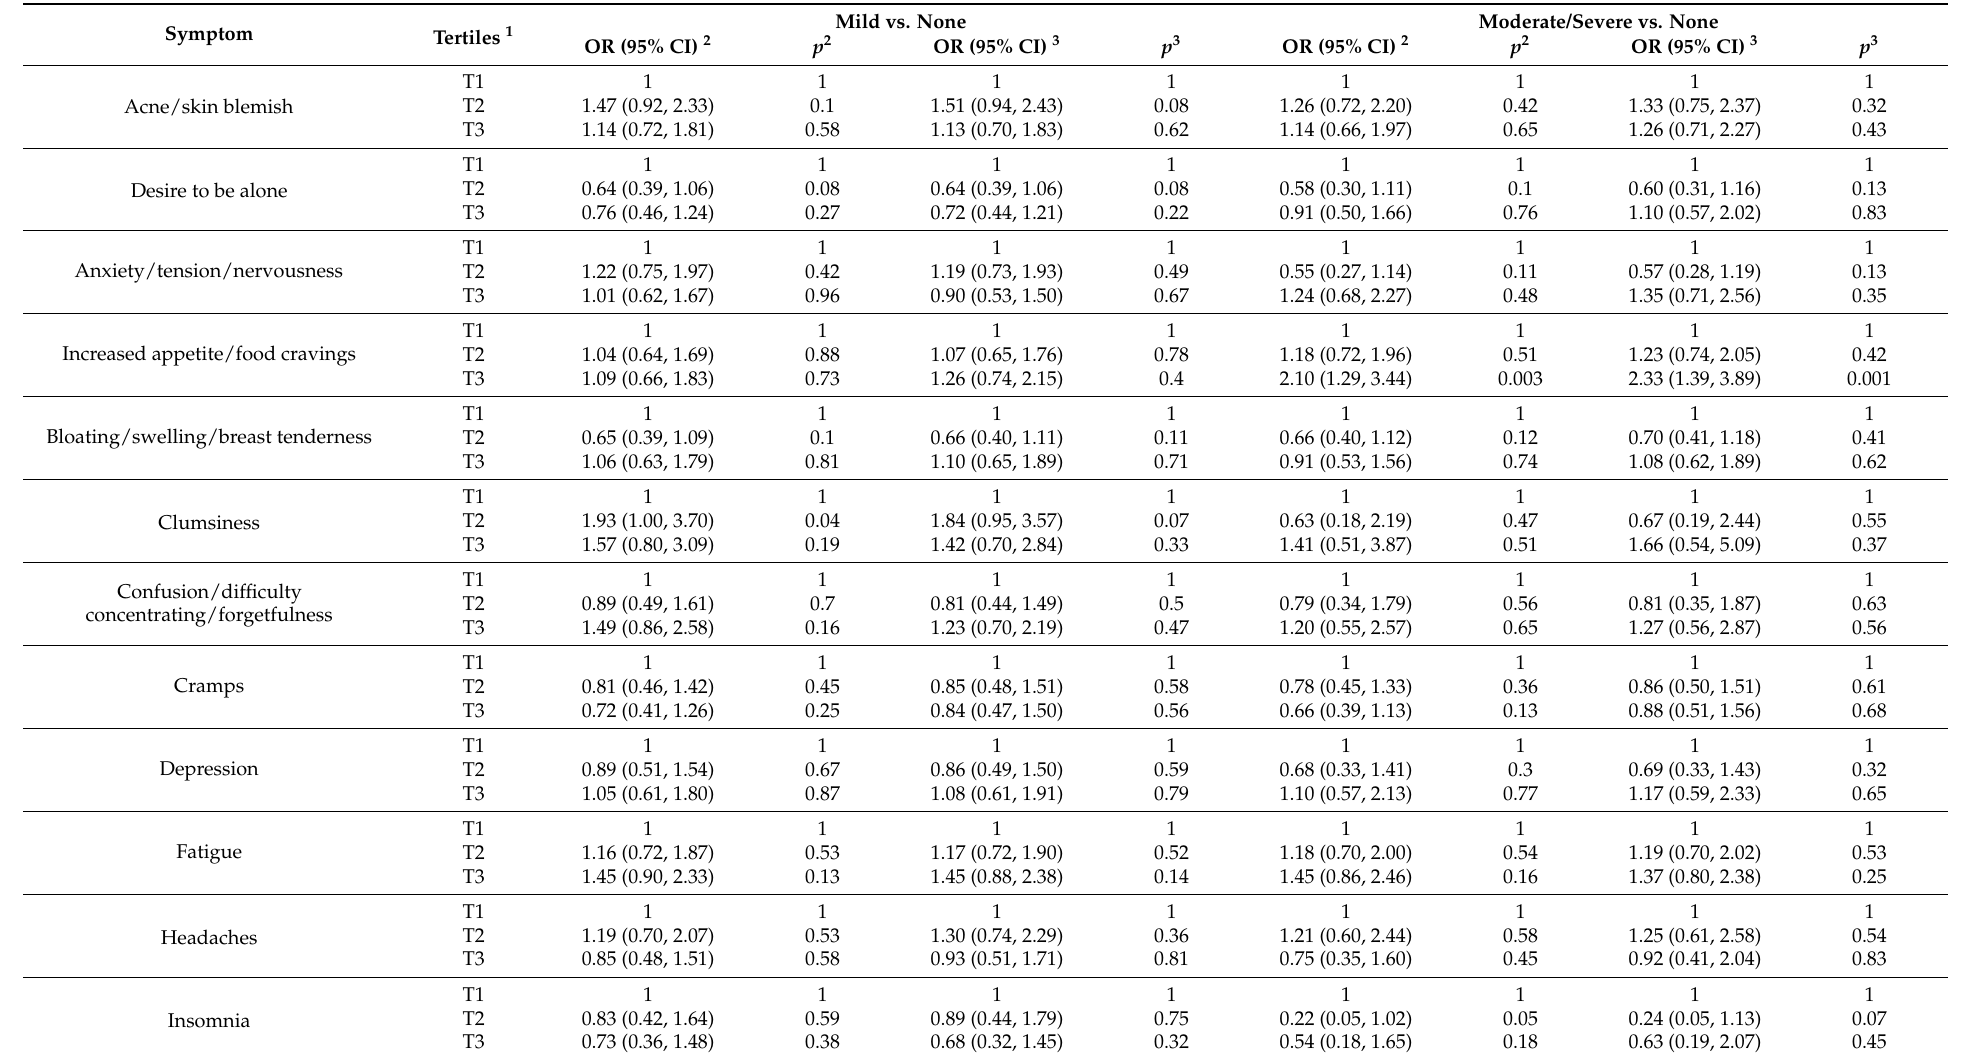
Table 2. Unadjusted and adjusted Odds Ratios and 95% CIs for the association between tertiles of plasma beta-cryptoxanthin and premenstrual